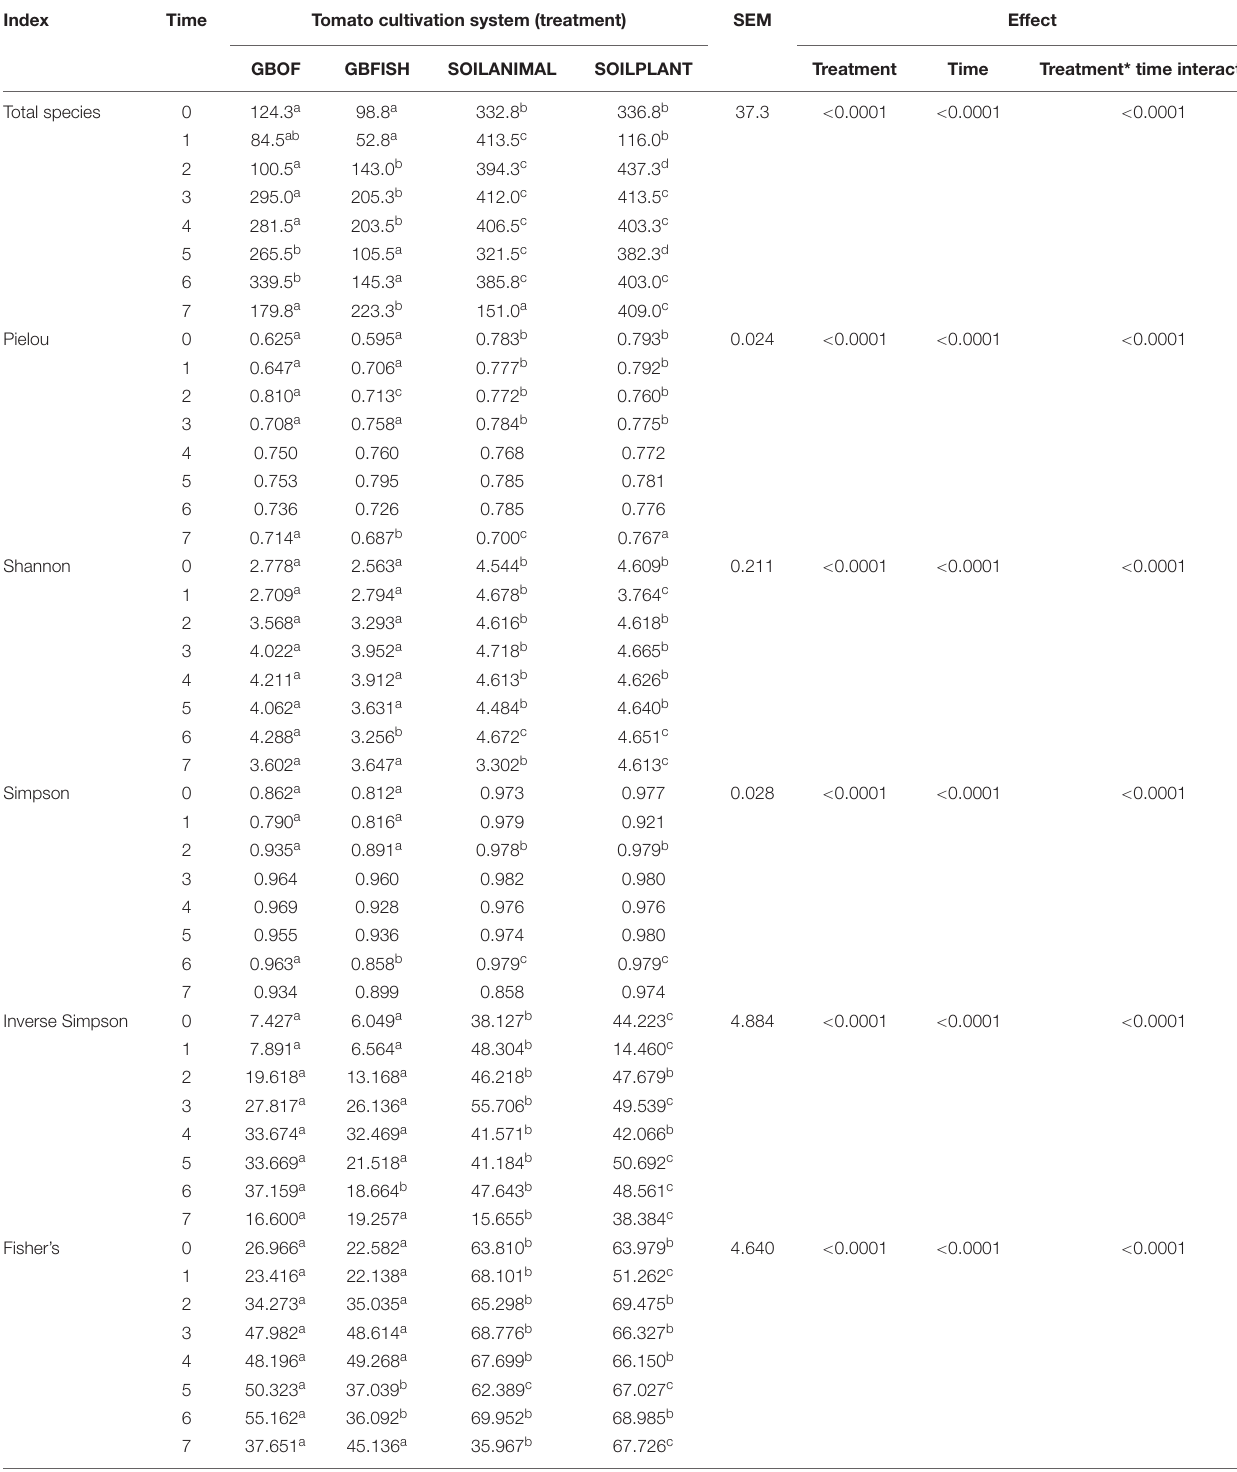
TABLE 3 | Effect of tomato cultivation system (GBOF, GBFISH, SOILANIMAL, and SOILPLANT) on species richness (total species), diversity (Shannon, Fisher’s alpha, Simpson and Inverse Simpson indices), and evenness (Pielou’s index) for all the 8 time points ( n = 3).